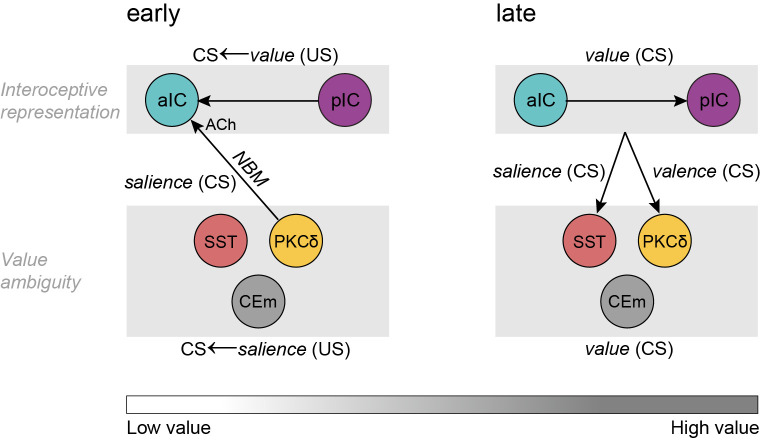
Hierarchical interactions in IC↔CE/NBM circuitry.(Left) Stimulus salience at the lower hierarchical level in the amygdala promotes interoceptive models from the IC via CEPKCδ when uncertain about value. In the absence of interoceptive value in CE CS salience engages NBM-aIC interaction to update intra-insular models. (Right) Insular interoceptive models about stimulus values are recruited by CE and segregate into salience and valence dimensions, which are differentially projected onto CE microcircuitry.